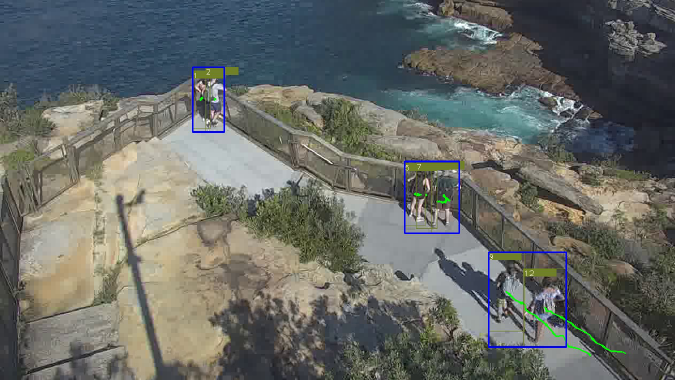
Figure 2. Demonstration of the trajectory analysis API: grouping and trajectories for a duration of 2 s (60 consecutive frames) with trajectories been shown in